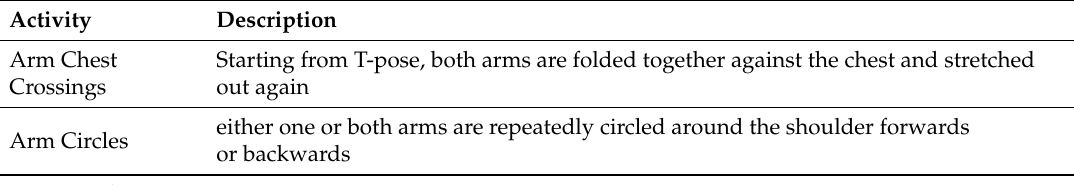
Table 1. Descriptions of activity